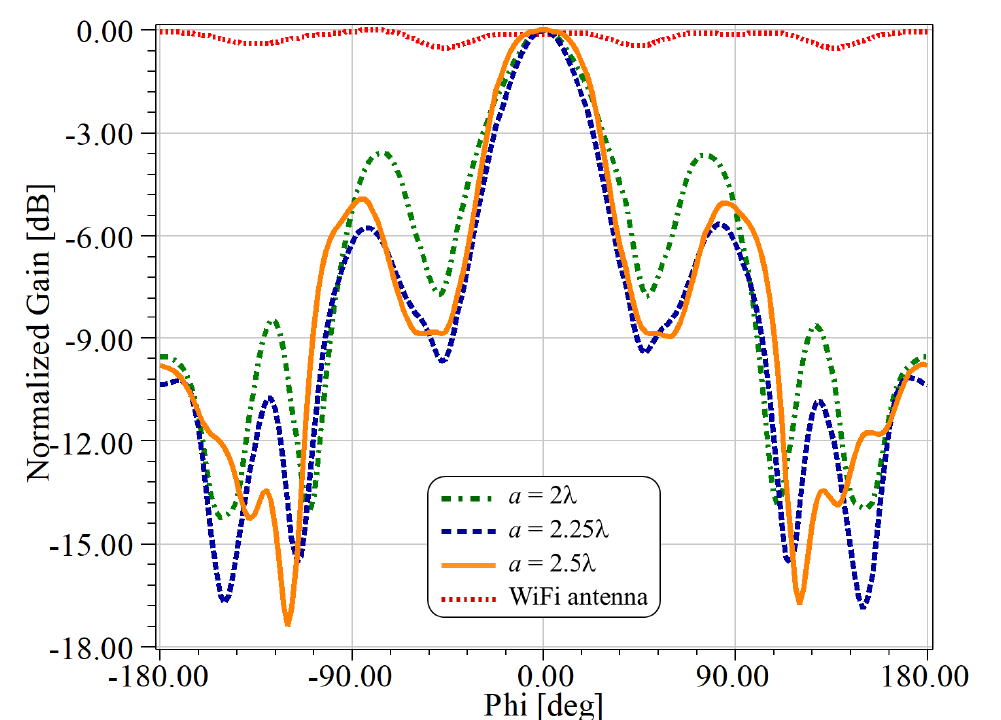
Figure 3. Comparative results for the antenna with (orange, blue and green lines) and without (red- dotted line) the Bragg reflector structure. Calculations were made for different a –values considering f = 5.7GHz, with − 180 ◦ < φ < + 180 ◦ , along the H-plane ( θ = 90 ◦ ). a = 2.25 λ produced the lowest side